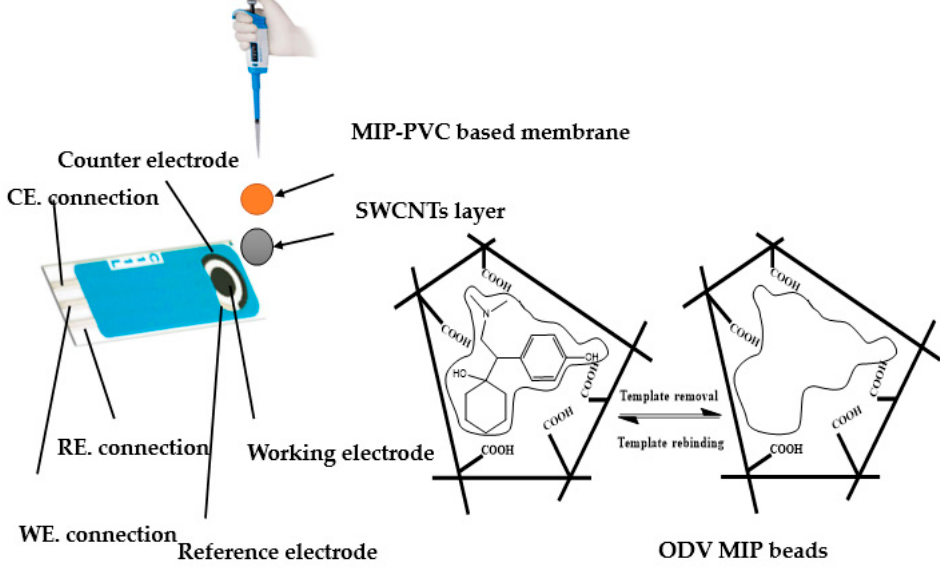
Figure 1. Schematic diagram for the sensor design and the pathway of the imprinting process.